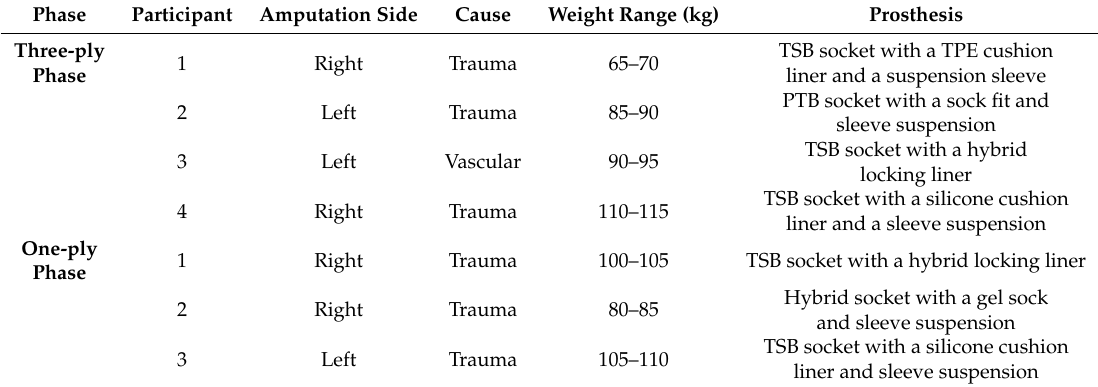
Table 1. Summary of participants’ information. Prosthesis: Total Surface Bearing (TSB), Thermoplastic Elastomer (TPE), Patellar Tendon Bearing